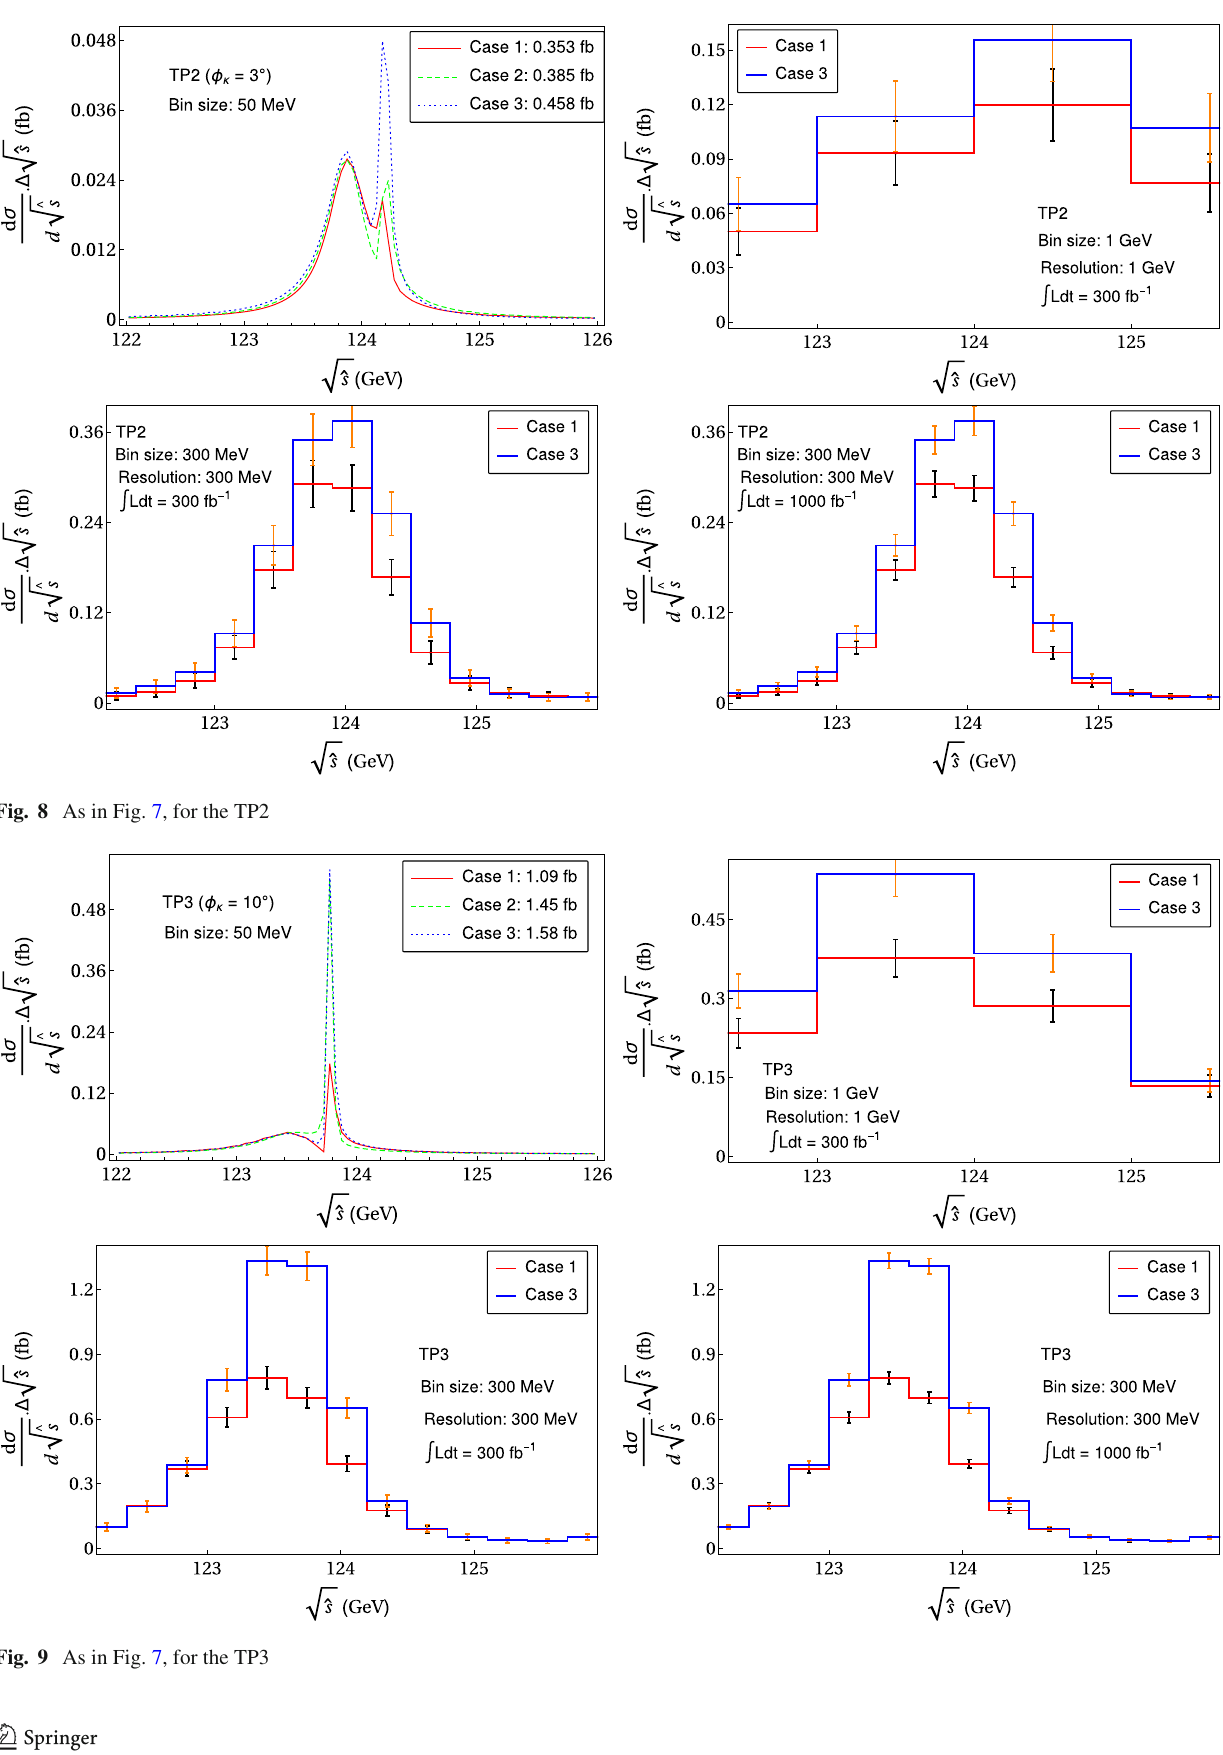
Fig. 9 As in Fig. 7, for the